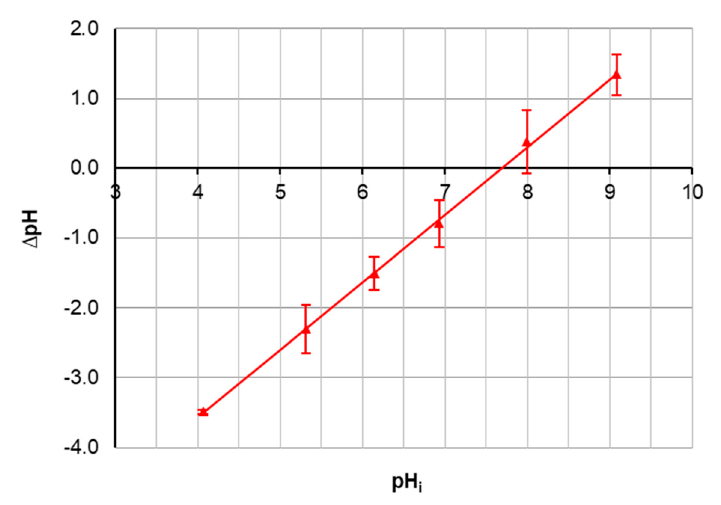
Figure 6. pH i versus Δ pH for the Mn-biosorbent hydrogel beads.